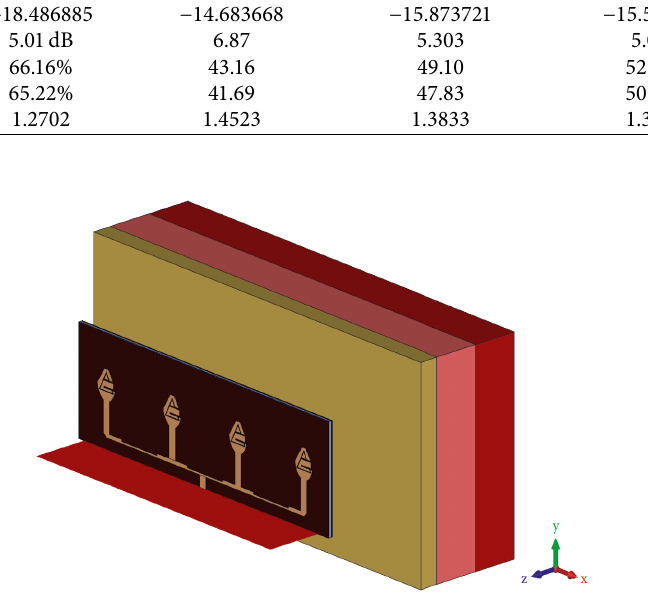
Figure 43: On-Body simulation setup for 1 × 4 antenna